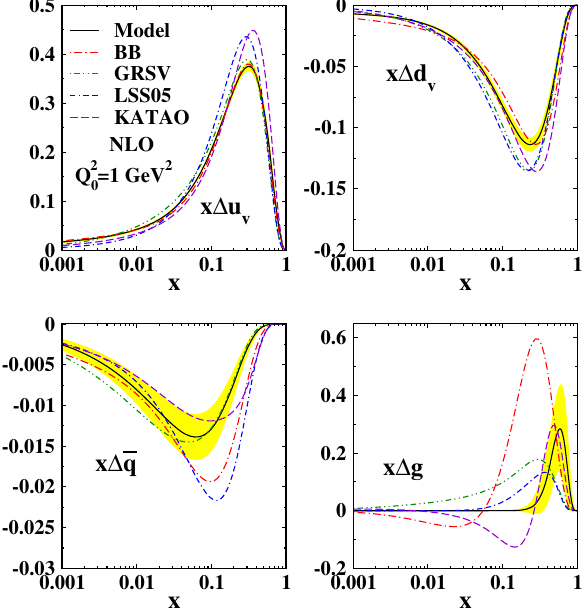
= 1 GeV 2 as a function 0